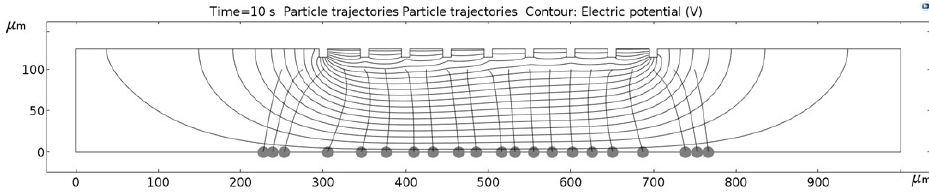
Figure 12. Computed particle trajectories and electric potential for the Step electrode geometry.